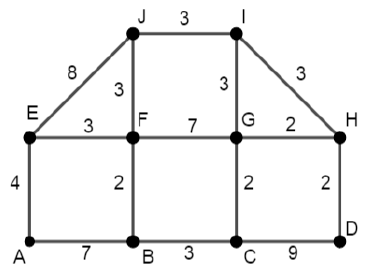
Figure A1. Scheme to problem 1.